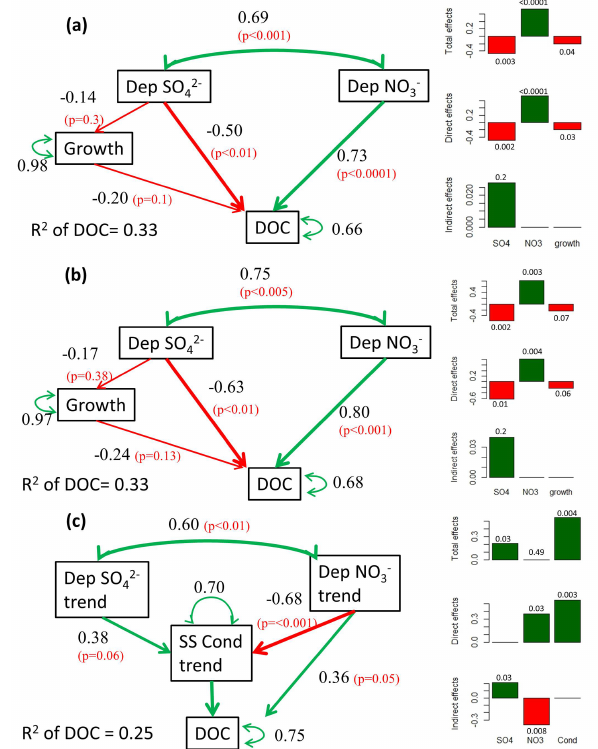
Figure 7. Diagrams of the structural equation models that best ex- plain the maximum variance of the resulting trends of DOC concen- trations in soil solution for (a) all the cases, (b) cases with low or medium throughfall inorganic N deposition (<15kgNha − 1 yr − 1 ) , and (c) cases with high throughfall inorganic N deposition (>15kgNha − 1 yr − 1 ) with mean or trends in annual SO 2 − NO − deposition (%yr − 1 ) with direct and indirect effects through 3 effects on soil solution parameters (trends of conductivity in µScm − 1 ) and mean annual stem volume increment (growth) in m 3 ha − 1 yr − 1 ) . p values of the significance of the corresponding effect are between brackets. Green arrows indicate positive effects and red arrows indicate negative effects. Side bar graphs indicate the magnitude of the total, direct and indirect effects and their p